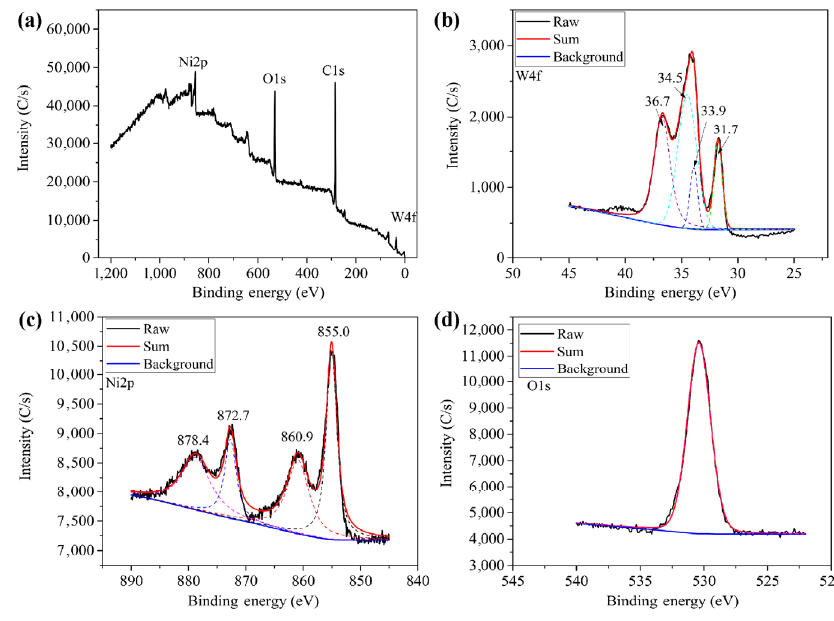
Fig. 10 XPS spectra of non-irradiated YN6 wear tracks: (a) surface scan; (b) W4f; (c) Ni2p; (d) O1s.